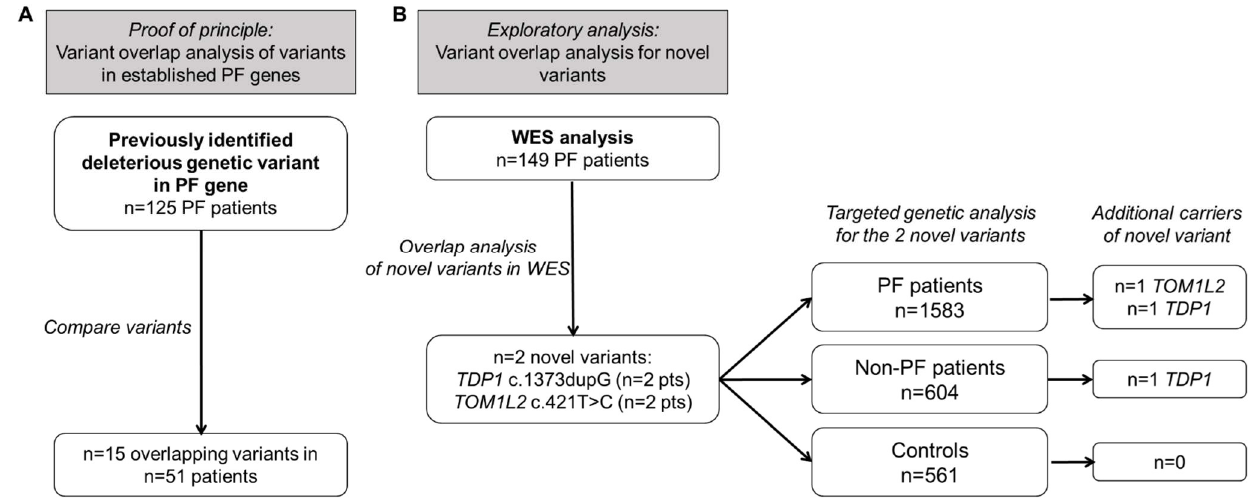
Figure 1. Variant overlap analysis in unrelated Dutch patients with pulmonary fibrosis (PF). ( A ) proof of principle for variant overlap analysis showing the number of PF patients from the ILD Biobank with a previously identified deleterious variant in a known PF gene. Deleterious variants had been classified as pathogenic, likely pathogenic, or a variant of uncertain significance (VUS). ( B ) PF cohort for identification of novel PF genes by variant overlap analysis and screening of a cohort of PF and non-PF patients and controls for these novel variants. PF = pulmonary fibrosis.